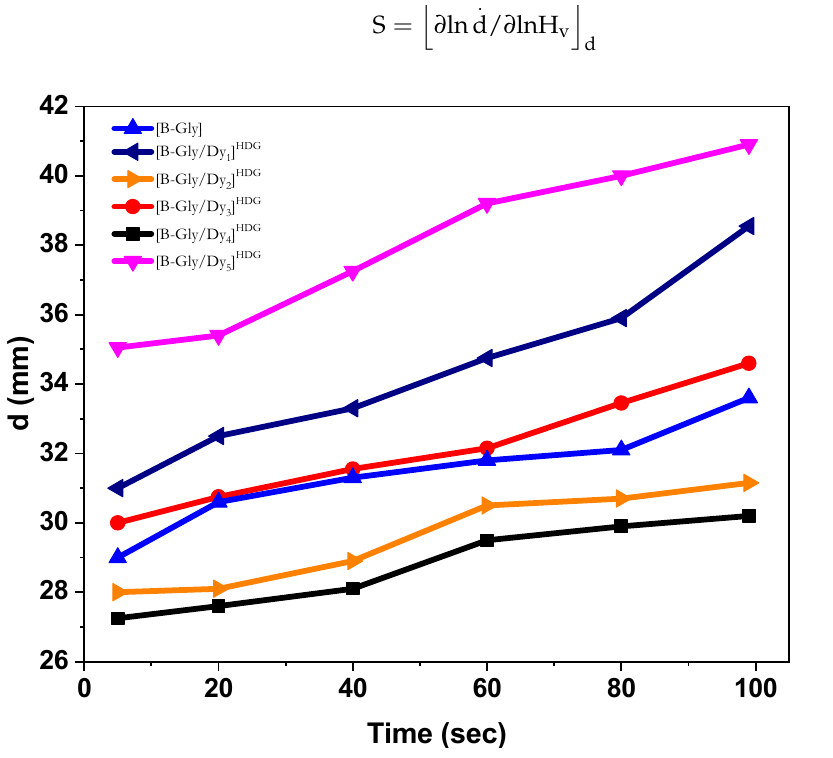
Figure 8. Variation of indentation length with time at constant load 100 gf.